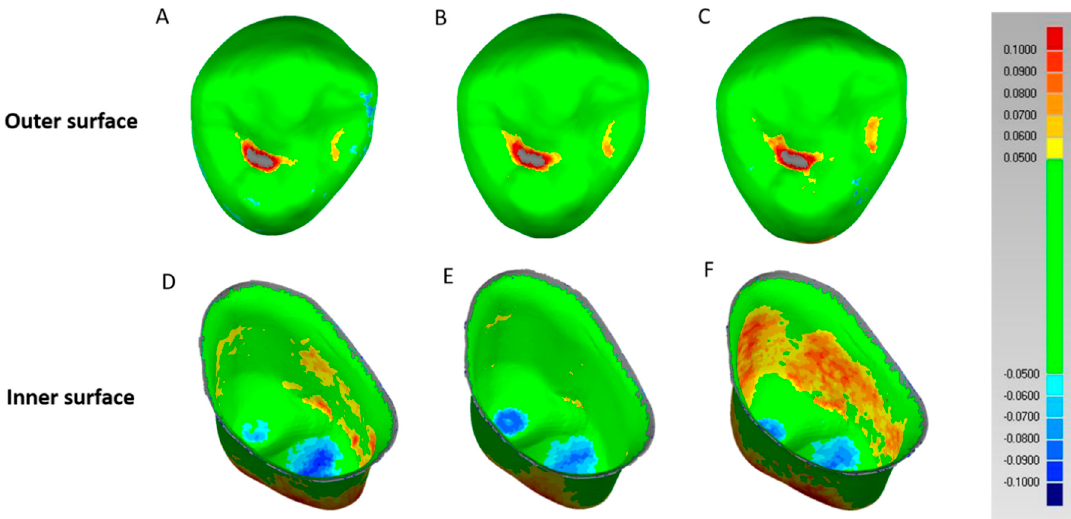
Figure 3. Evaluation of the trueness of crowns, prepared using the three types of ceramic blocks, in the outer and inner surfaces. ( A ) Color difference in the outer surface of the AM crown, showing the superimposing of 3D data. ( B ) Color difference in the outer surface of the IPS crown, showing the superimposing of 3D data. ( C ) Color difference in the outer surface of the CEL crown, showing the superimposing of 3D data. ( D ) Color difference in the inner surface of the AM crown, showing the superimposing of 3D data. ( E ) Color difference in the inner surface of the IPS crown, showing the superimposing of 3D data. ( F ) Color difference in the inner surface of the CEL crown, showing the superimposing of 3D data.